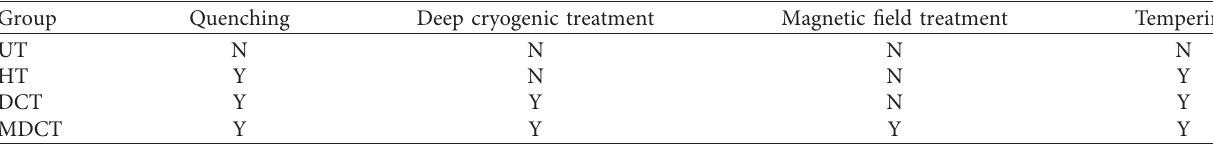
Table 2: Process program.